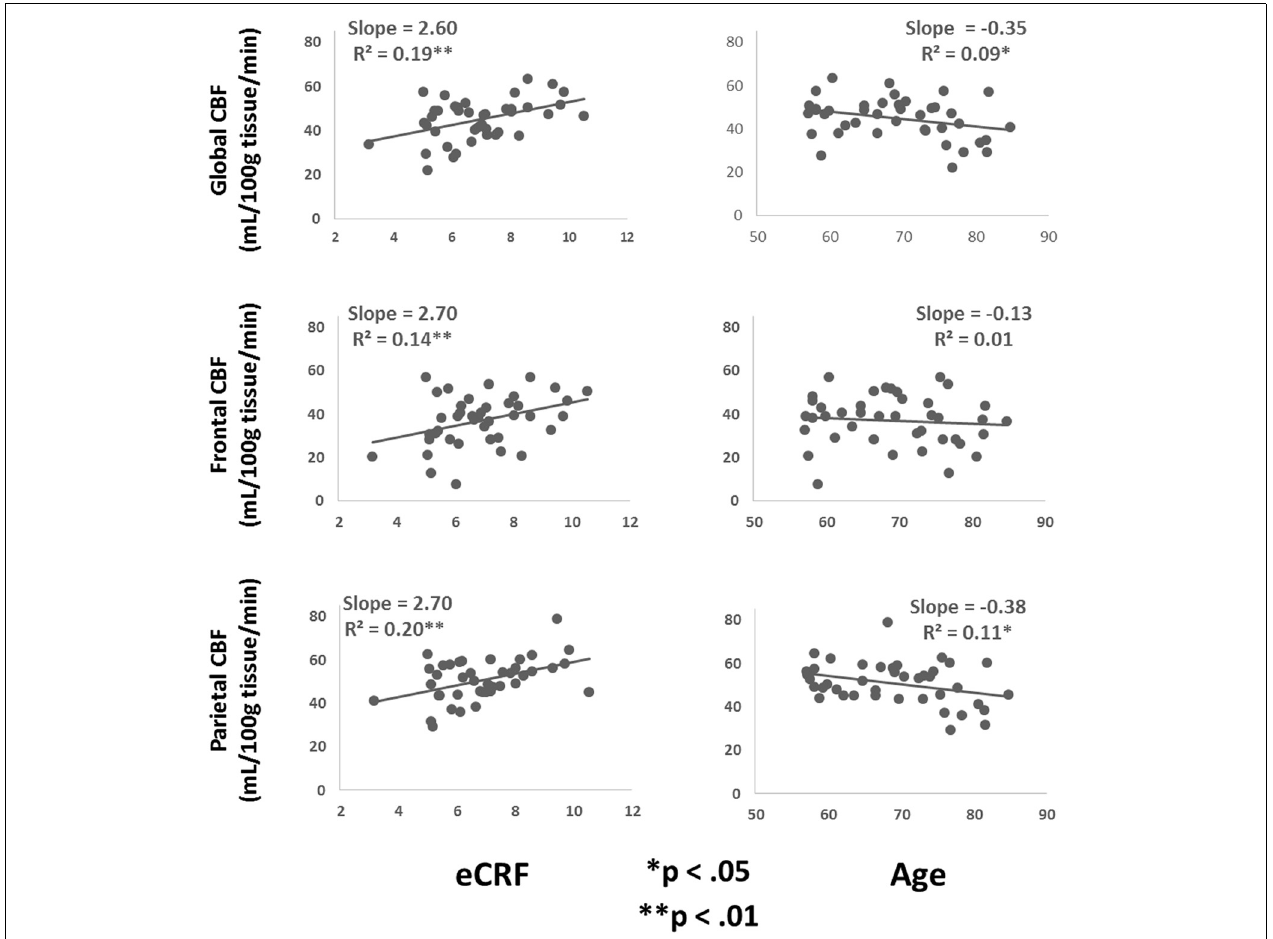
FIGURE 3 | Scatter plots depicting the relationships between CBF and eCRF (left column) and age (right column) in global (top), frontal (middle), and parietal (bottom) gray matter regions of interest.